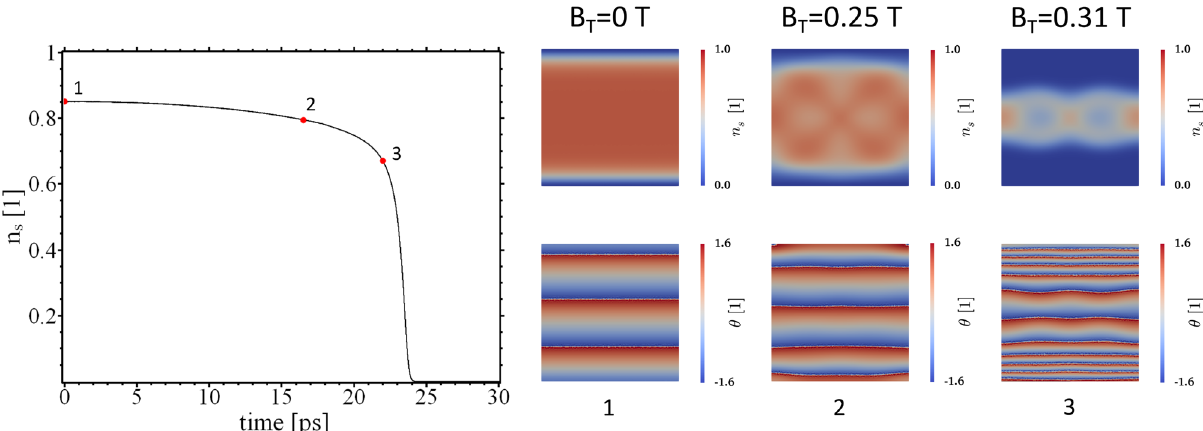
0.95 j c and application of a STE-pulse with a T = =